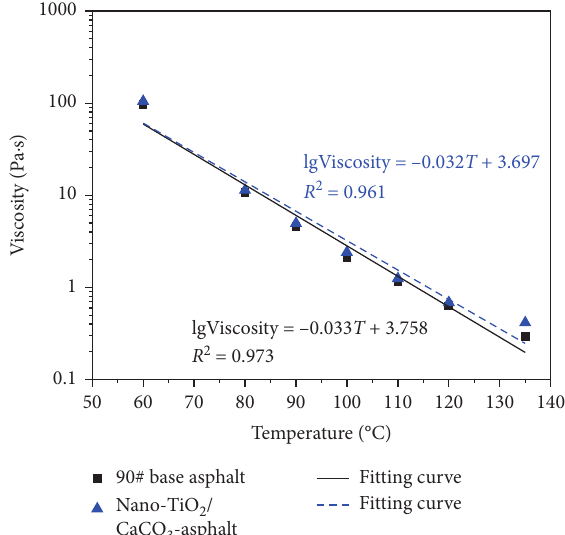
Figure 5: The viscosity-temperature curve of base bitumen and nano-TiO